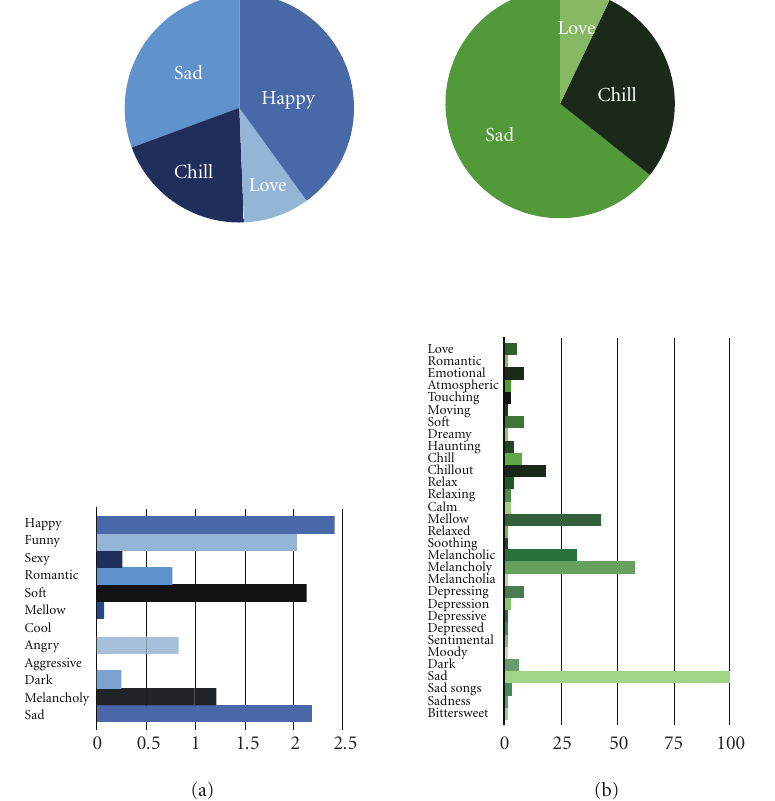
Figure 1: Accumulated LSA correlation between (a) the lyrics of the song “Nothing else matters” and 12 a ff ective terms, compared to (b) the actual user-defined emotional tags at